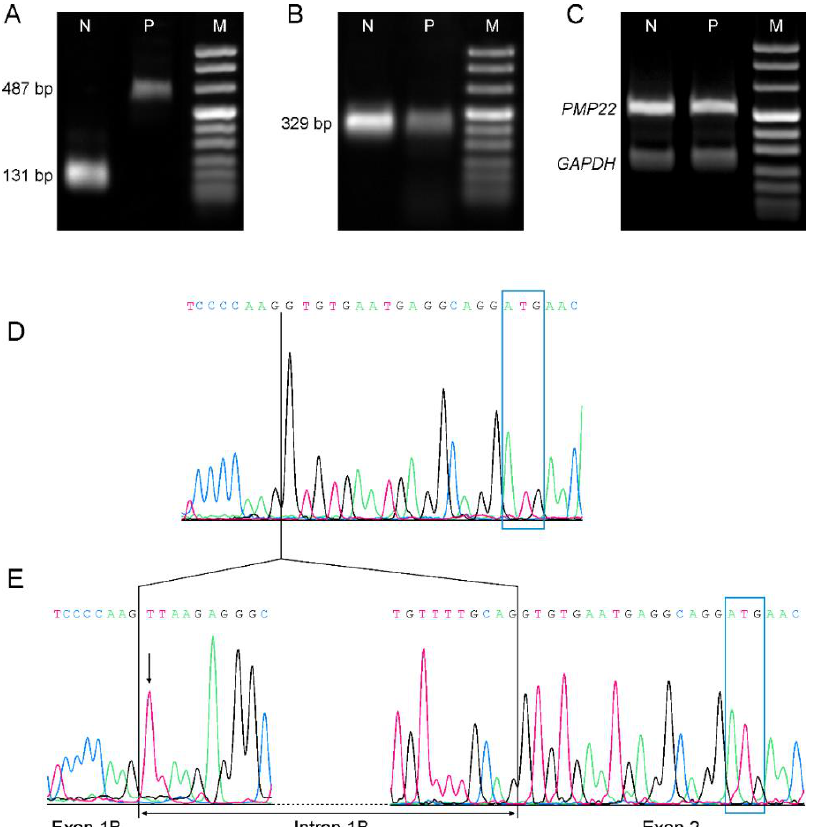
Figure 3. Comparative transcriptional and retro-transcriptional analysis . ( A – C ): Real-time polymerase chain reaction (RT-PCR) of mRNA extracted from archived frozen sural nerve biopsies of a normal control (N) and patient III-8 (P), separated by 2% agarose. ( D , E ): Nucleotide sequence of GJB1 cDNA, as obtained from sural nerve biopsy of a normal control ( D ) and patient III-8 ( E ). ATG start codon is outlined by the blue rectangles. ( A ) Analysis of GJB1 RNA splicing using primers spanning exon 1B and the first 23 nucleotides of exon 2 (from g.13017 to g.13503): N shows an amplicon of 131 bp, as expected after regular mRNA splicing. In P, the same amplicon has an estimated length of 487 pb, which is consistent with the inclusion of intron 1B. ( B ) RT-PCR of GJB1 exon 2 (from g.13615 to g.13943) showed a decreased expression of the patient’s cDNA. A semiquantitative densitometric analysis demonstrated a 70% reduction of transcript level in P when compared to N. ( C ) Both PMP22 (438 bp, spanning from exon 1 to exon 4) and the housekeeping GAPDH (252 bp, spanning from exon 6 to exon 8) cDNAs in patient P had similar expression levels to control N. ( D ) Nucleotide sequence of a normal control: GJB1 exon 1B and exon 2 are joined together. A vertical line represents the boundary between exon 1B and exon 2. ( E ) Nucleotide sequence of patient III-8: an arrow points to the c.-17+1G>T mutation. The change of the canonical splice site sequence causes the retention of the whole (356 nt-long) intron 1B into the mRNA. Only the first and last 10 nucleotides of intron 1B are shown for a better output.